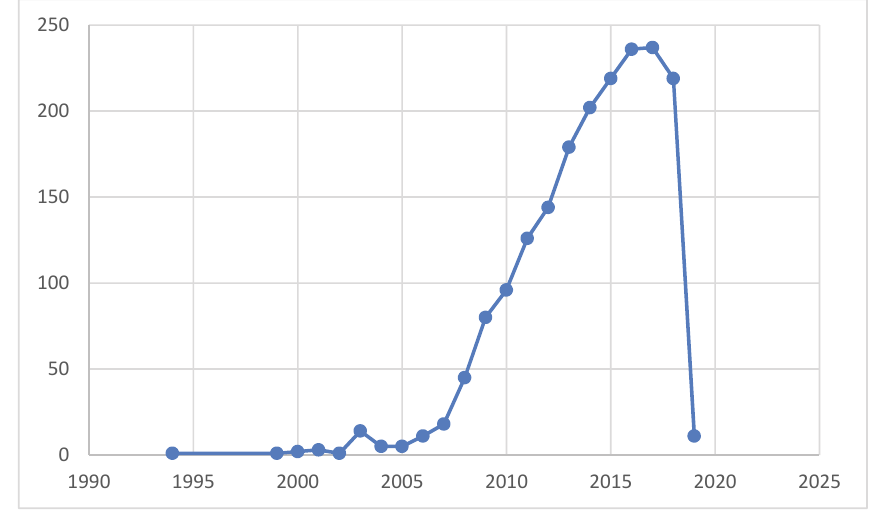
Fig. 1. The Scopus publications on the analysis of social media and knowledge management from 1994 to